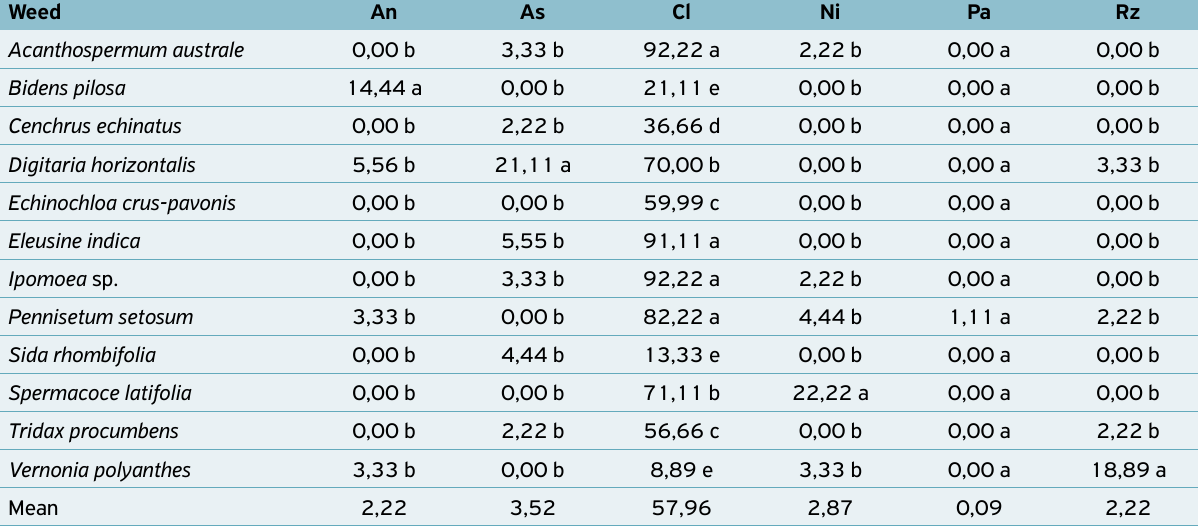
Table 2. Incidence of contaminating fungi found in seeds of different weed species collected in Cerrado areas, Gurupi, Tocantins, Brazil.